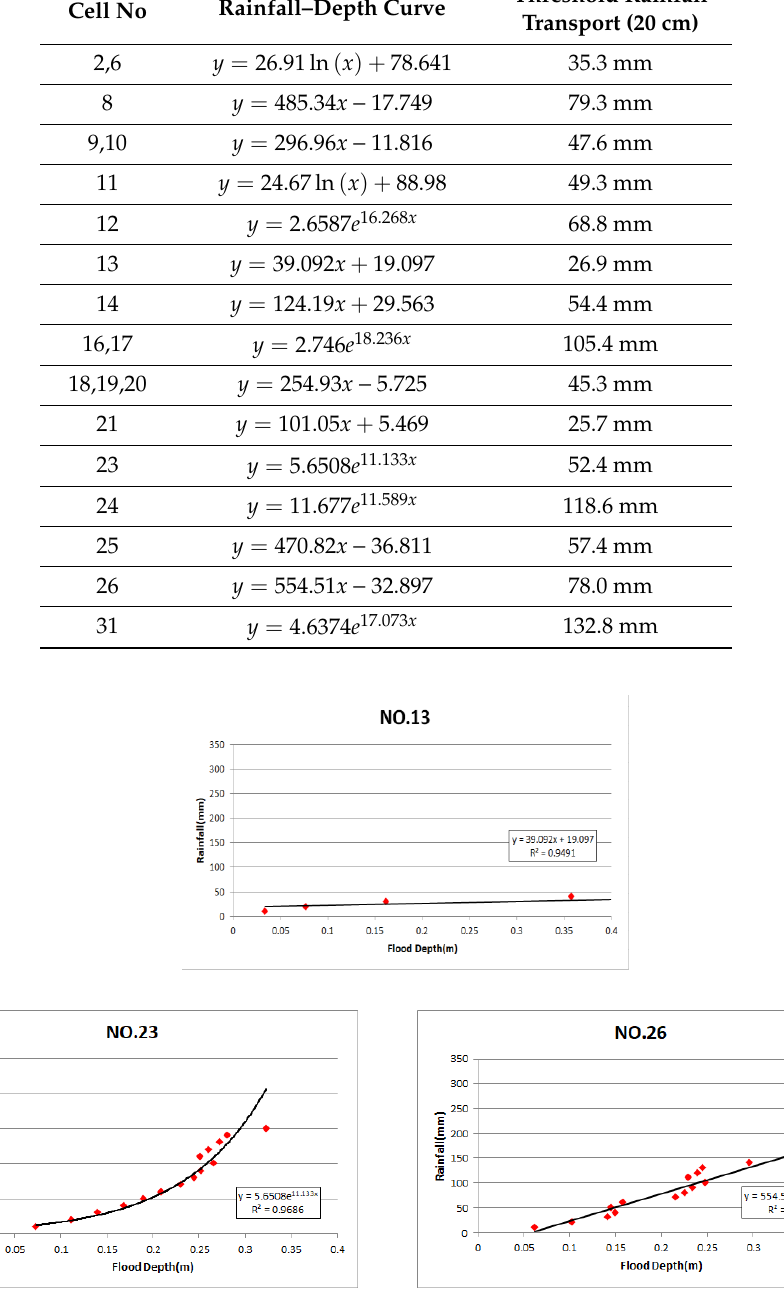
Figure 16. Rainfall – depth curve. Figure 16. Rainfall–depth